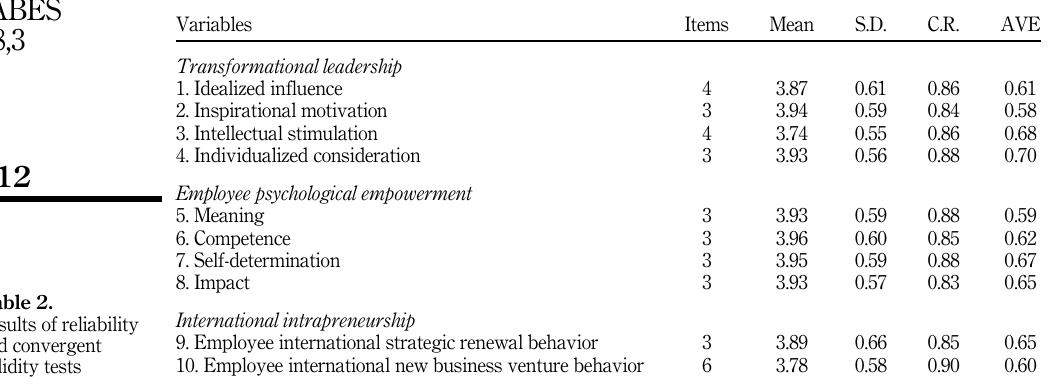
Table 2. Results of reliability